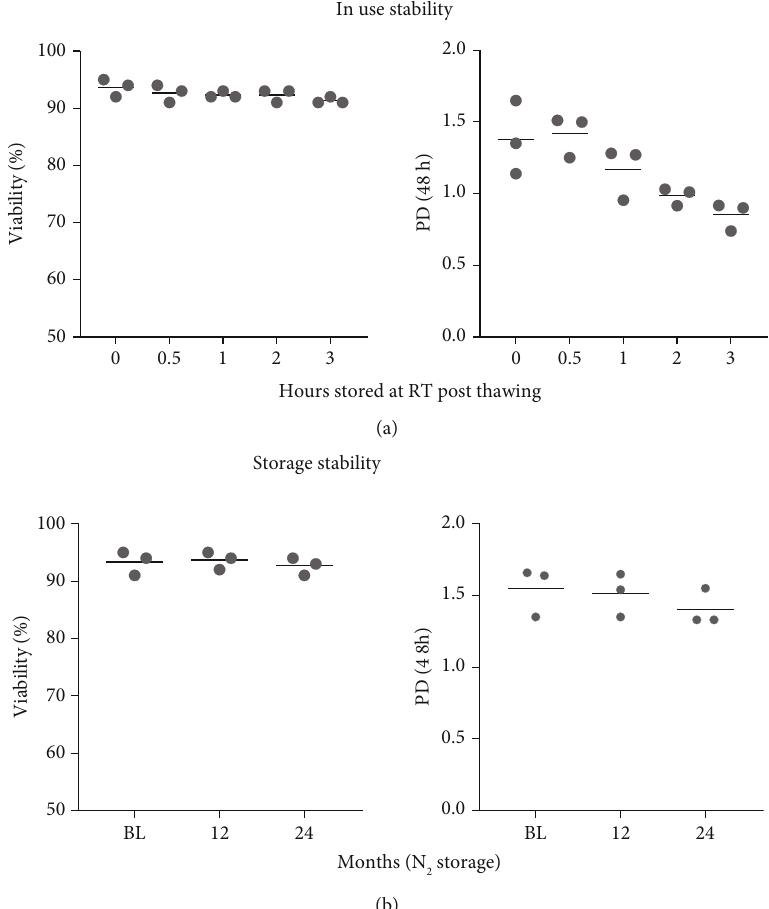
Figure 4: In use and storage stability. (a) In-use stability of thawed cells at room temperature (RT) within three hours. (b) Long-term stability of nitrogen stored CSCC_ASC over 24 months. PD: population doublings; BL: baseline. The line represents the mean